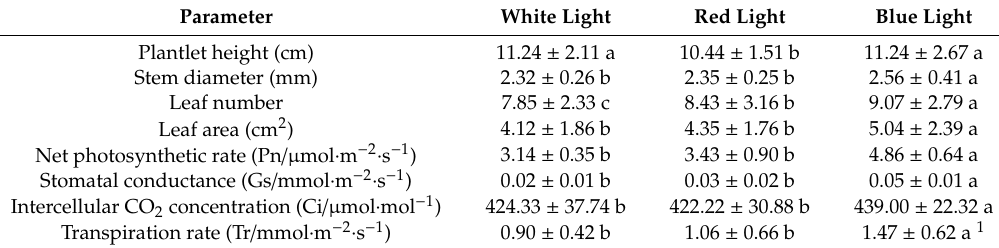
Table 1. Influence of di ff erent light qualities on growth traits in Camellia oleifera